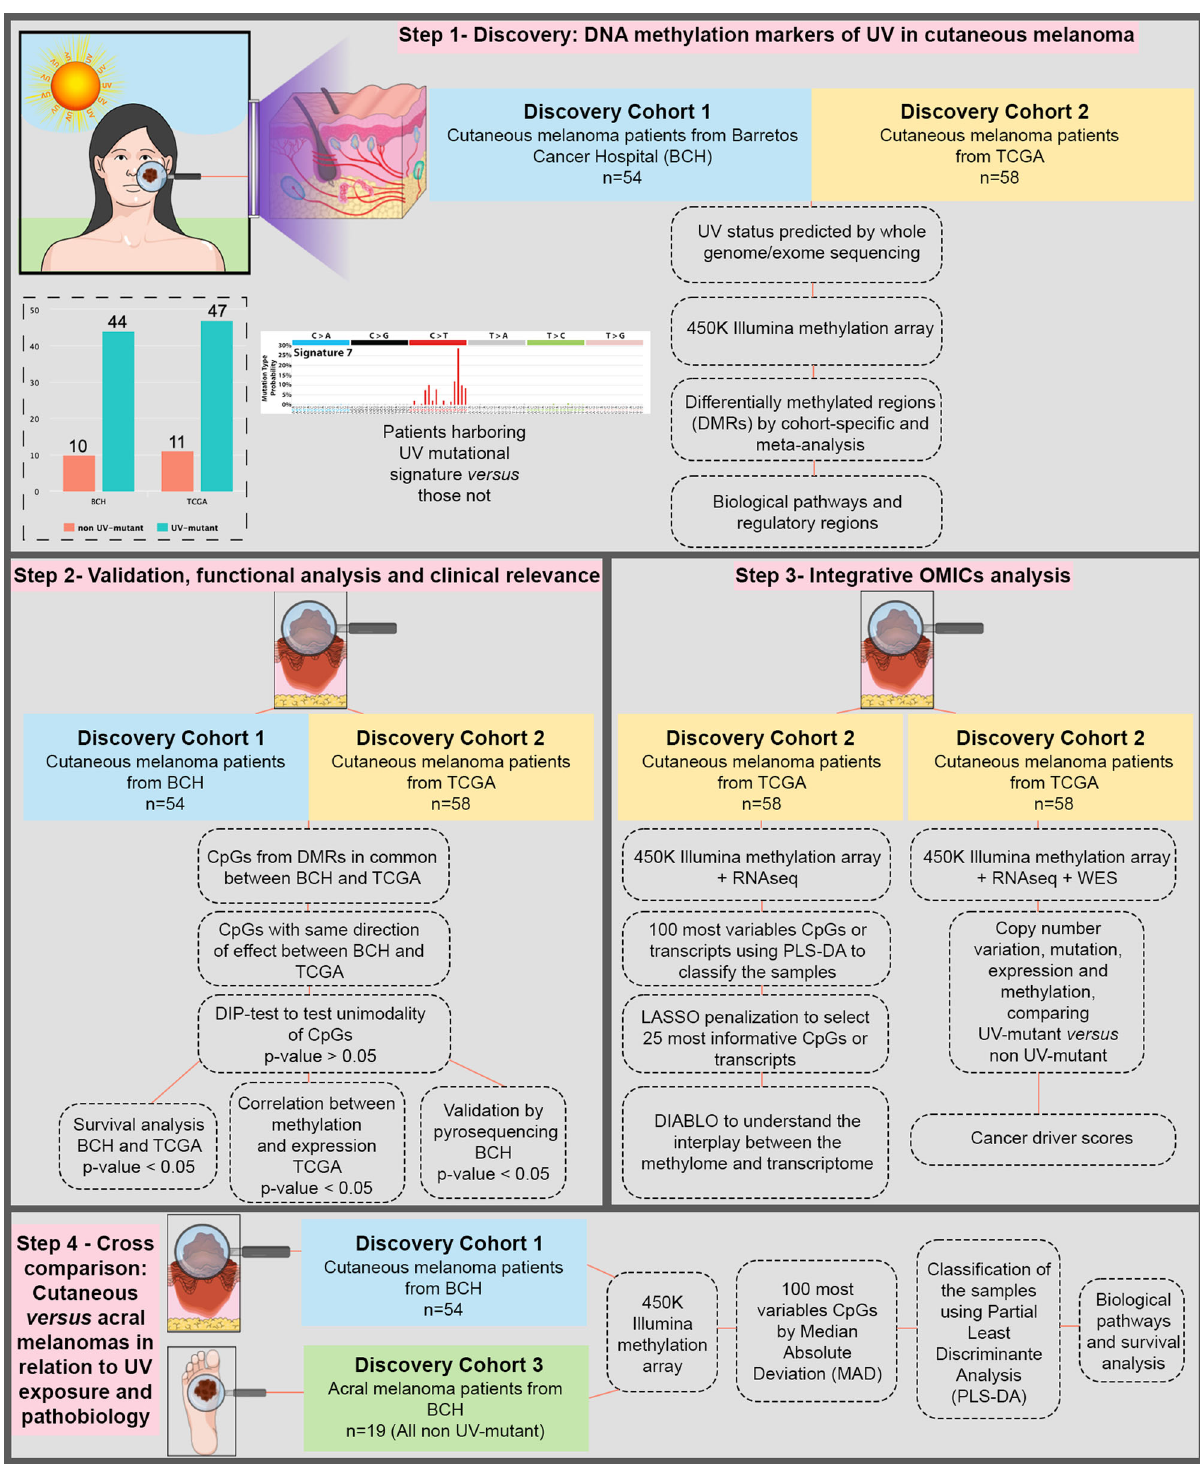
Fig. 1 Study design, resources and methodology. A major aim (steps 1 – 2) is the discovery and validation of genome-wide methylation alterations associated with the UV mutational signature in cutaneous melanoma, based on two independent cohorts. Another major aim (step 3) is assessing the discriminative potential of the DNA methylome versus transcriptome versus integrated methylome-transcriptome in differentiating between UV-mutant and non UV-mutant cutaneous melanomas. The integrative OMICs approach is expanded to include small nucleotide variants (SNVs) and copy number variants (CNVs) in order to assess cancer driver potential of prioritized differentially methylated genes. This is complemented by step 4, which investigates whether the DNA methylome could capture pathological and/or UV-related differences between major melanoma types predominantly associated with UV exposure (cutaneous melanoma) and those not (acral melanoma).